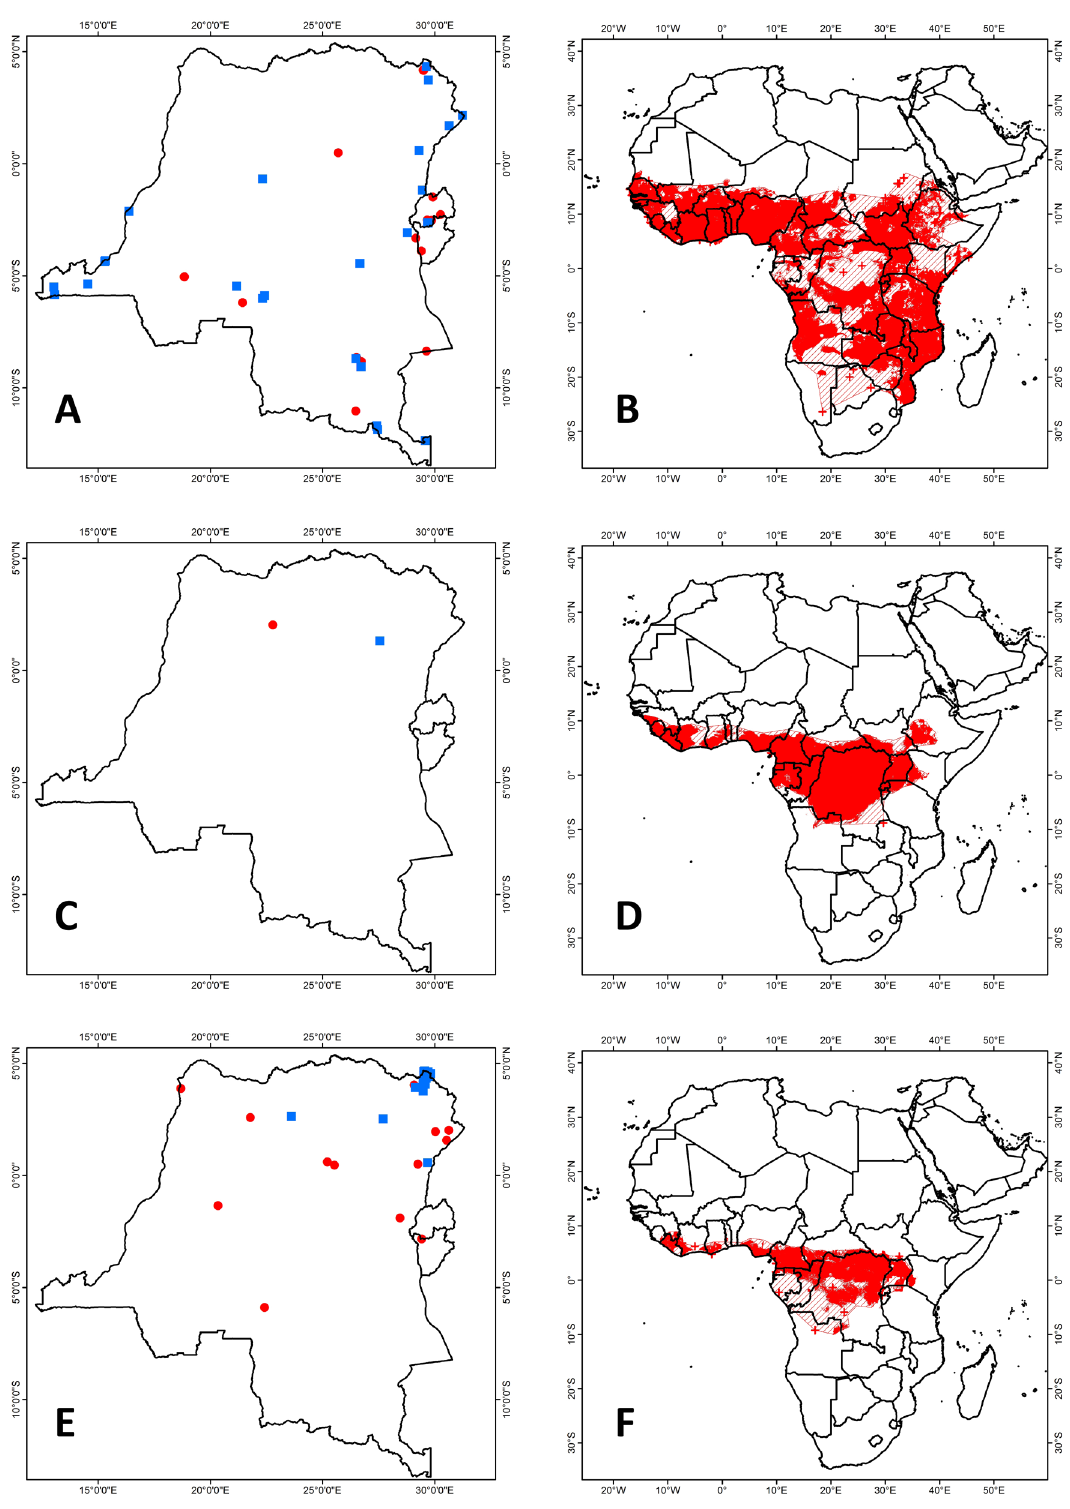
Fig. 22. Distribution maps. A–B . Nycteris macrotis Dobson, 1876. C–D . Nycteris major (K. Andersen, 1912). E–F . Nycteris nana (K. Andersen, 1912). A, C, E. Distribution in the CRB area. B, D, F.